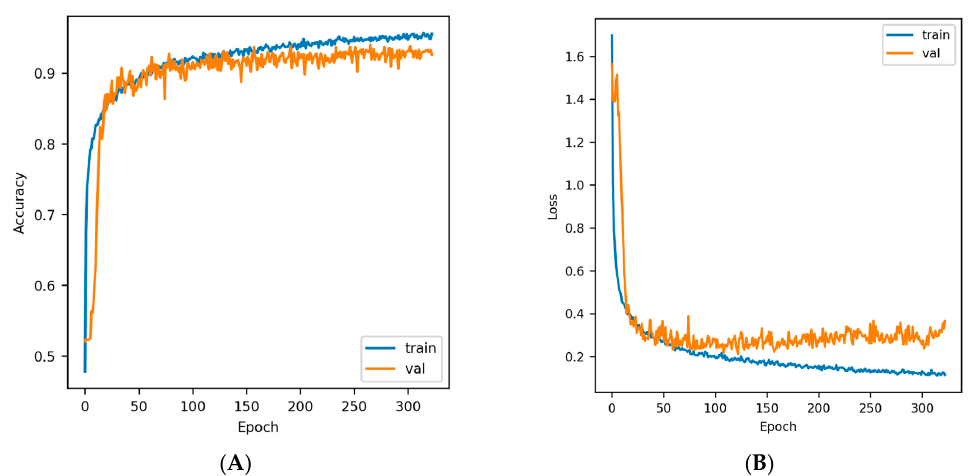
Figure 9. CNN training curves ( A ) Accuracy vs. Epoch; ( B ) Loss vs. Epoch.